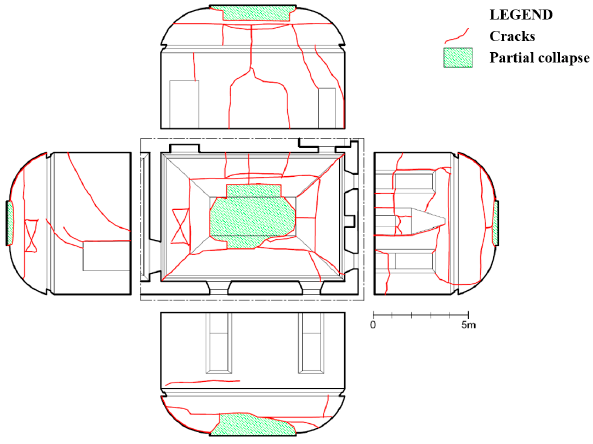
Figure 4. Crack pattern of damaged hall B. Reproduced with permission from [18].